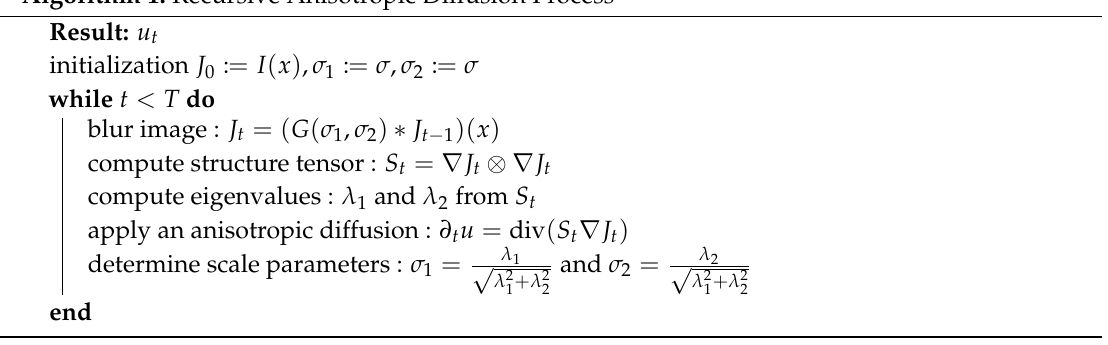
Algorithm 1: Recursive Anisotropic Diffusion